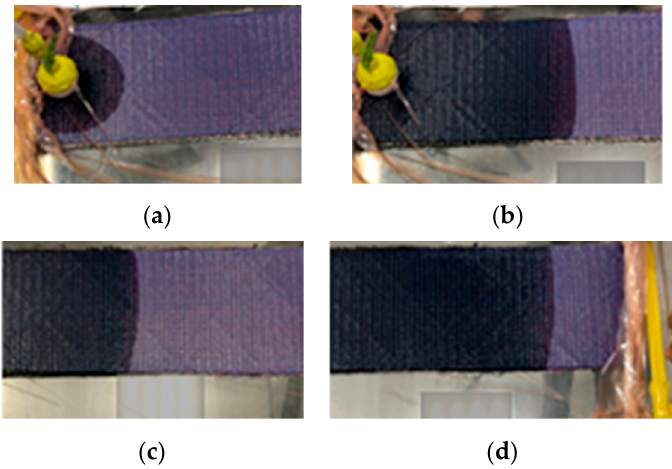
Figure 8. Sequence of representative images of flow fronts in the laminate manufacturing under vacuum assisted resin transfer (VARTM) process: ( a ) t = 10 s; ( b ) t = 100 s; ( c ) t = 1080 s and ( d ) t = 2055 s.